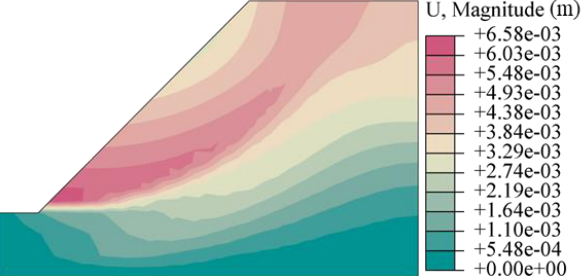
Figure 4. Equivalent displacement cloud calculated by the double strength reduction method.